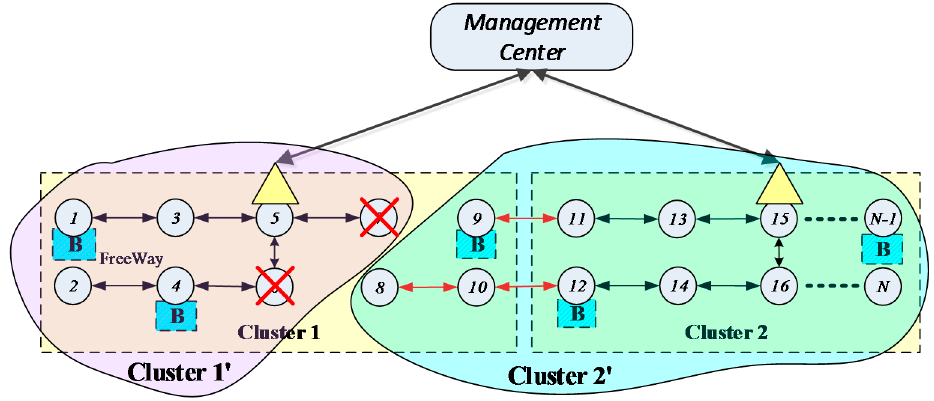
Figure 5. Illustration of cluster adjustment.